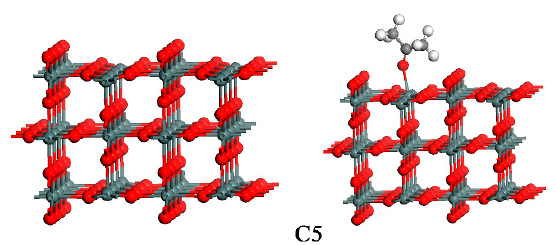
Figure 12. The four different adsorption configurations of acetone molecule on 2 × 2 SnO 2 (110) surface. C1: on stoichiometric SnO 2 surface; C2, C3: on defective SnO 2 surface; C4: on O 2 pre-adsorbed SnO 2 surface.